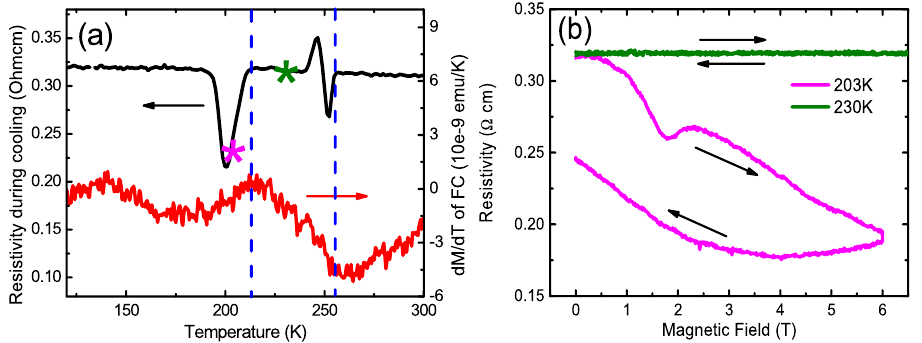
Figure 5. Electric transport of single wire. ( a ) Resistivity result measured during cooling with magnetic field of 60000 Oe applied perpendicular to the device plane, showing two anomalies at approximately 250 K and 200 K (left y axis), in comparison with dM/dT of FC magnetization (right y axis). Blue lines are for eye-guide. ( b ) Field dependent resistivity measured at 203 K and 230 K (temperatures marked with stars in ( a )). The arrows show the field